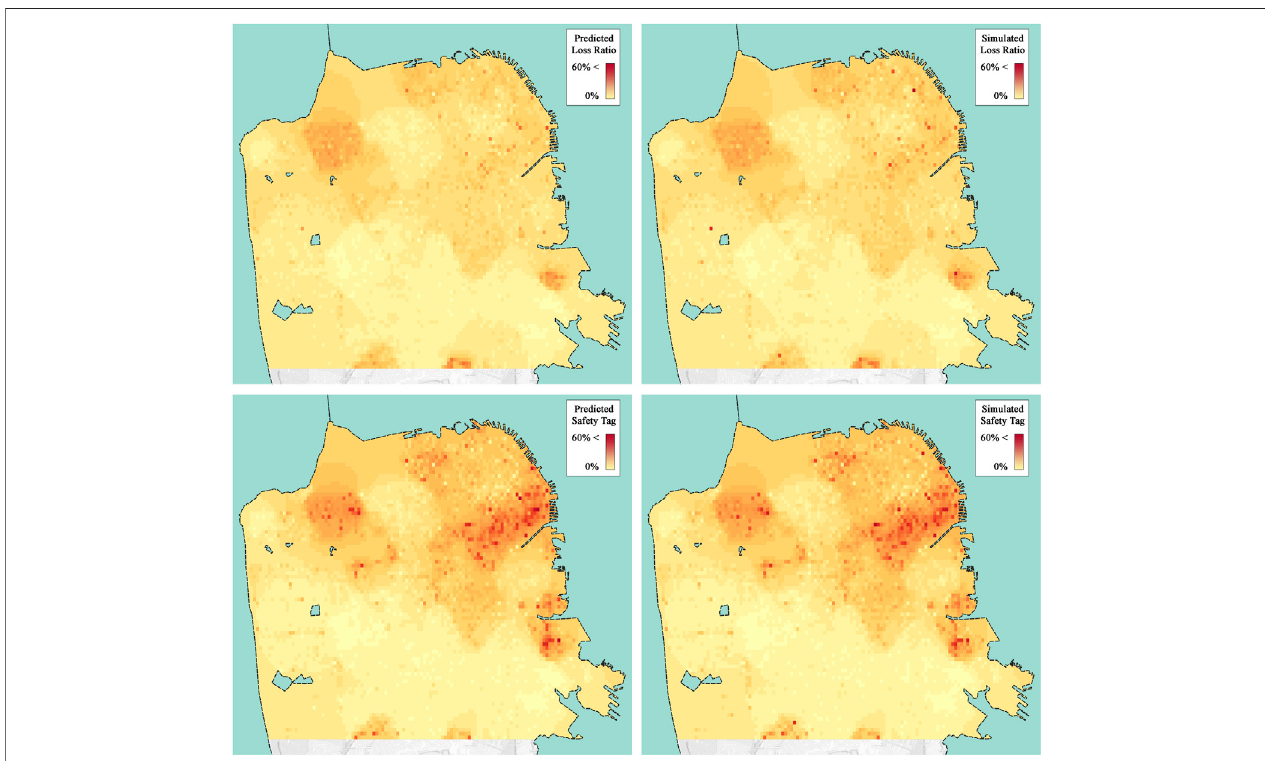
FIGURE 11 | Visualization of the labels obtained from work fl ow simulation and RD-GSxprediction. Although labels are obtained for individual buildings, the results are shown in the form of interpolated values on grids of size ∼ 150 m × 150 m to protect privacy.